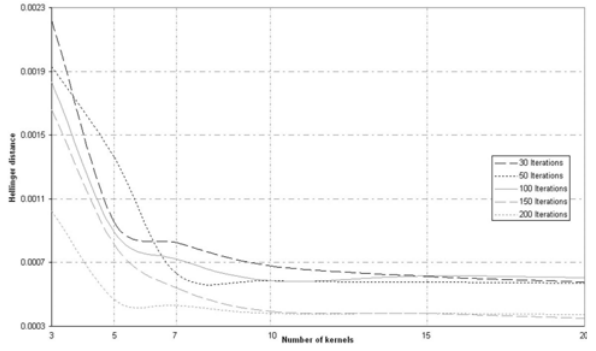
Fig. 8. Mean distance between the true PDF and FGM estimation with varying number of kernels. The number of iterations is a parameter.